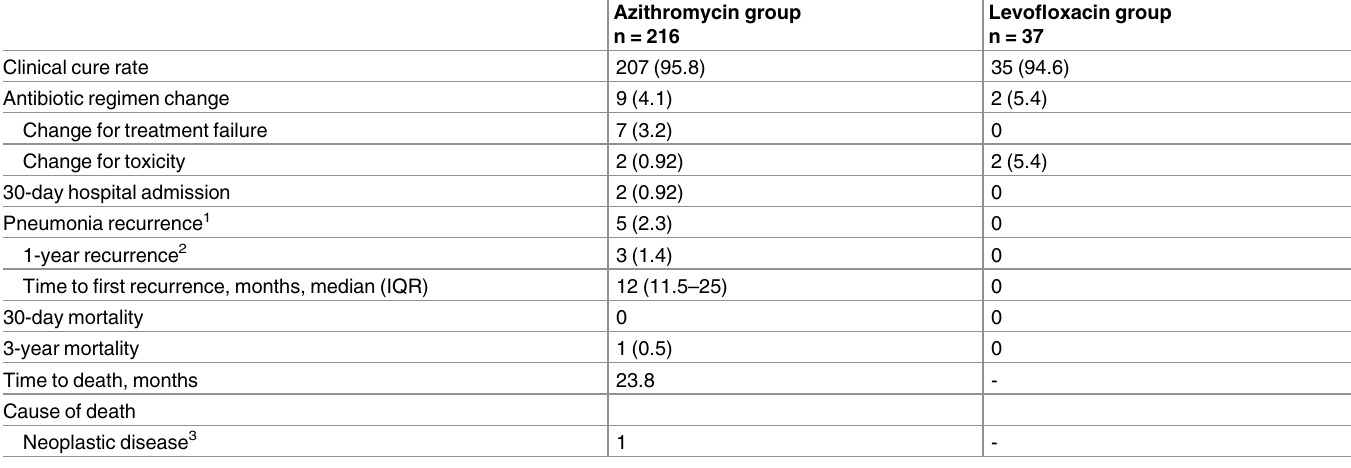
Table 3. Short-term and long-term outcome